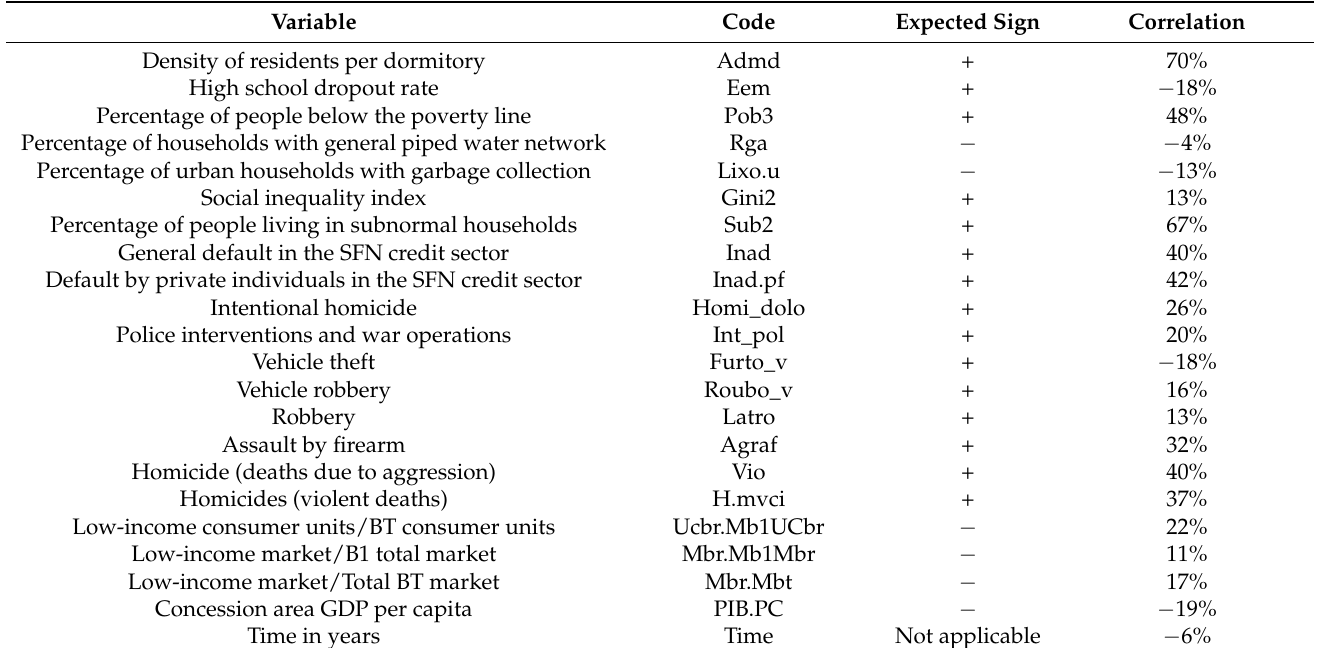
Table 2. Summary of variables and expected signs of the coefficients.